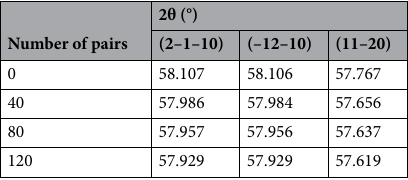
Table 1. Value of 2θ from phase analysis along (2–1–10), (–12–10) and (11–20) planes.